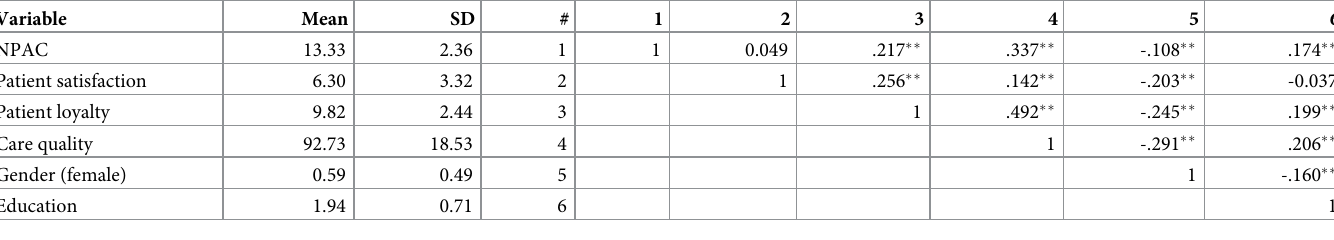
Table 3. Descriptive statistics and bivariate correlations of relevant variables ( n =